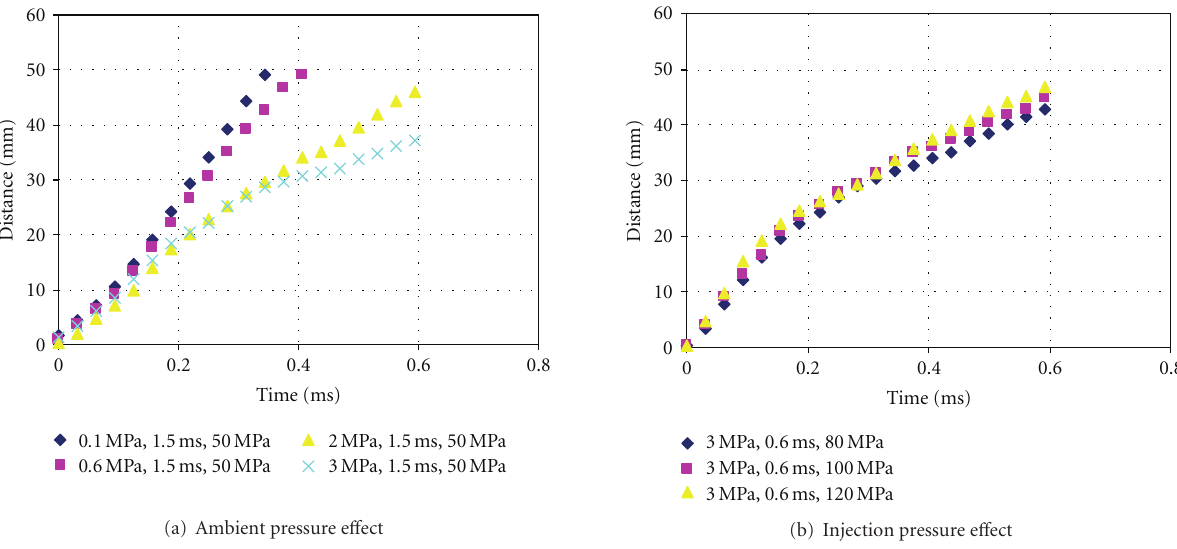
Figure 9: Spray tip penetrations at 300K ambient temperature, experimental results with Nozzle D. (a) Ambient pressure e ff ect 1.5 ms injection duration, 50MPa injection pressure; (b) injection pressure e ff ect 3Mpa ambient pressure, 0.6 ms injection duration.